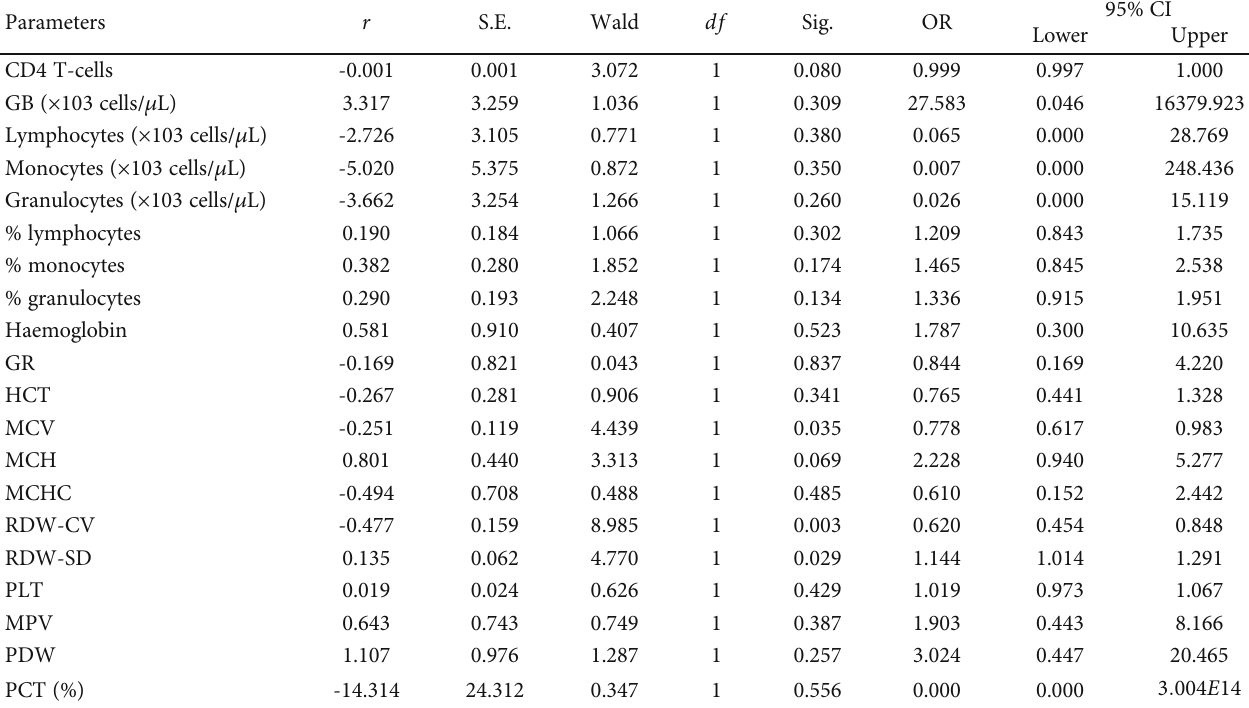
Table 5: Correlation of haematologic parameters and diabetes